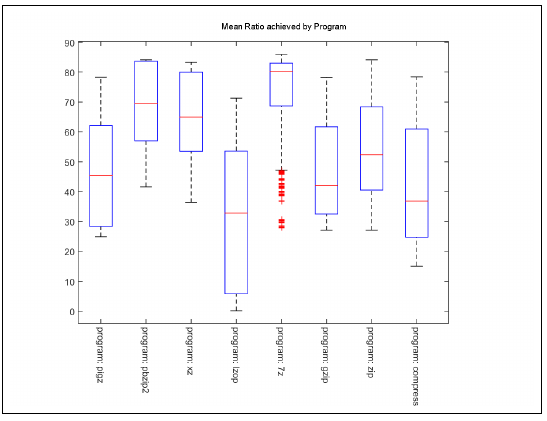
Figure 9: Average decompression time.